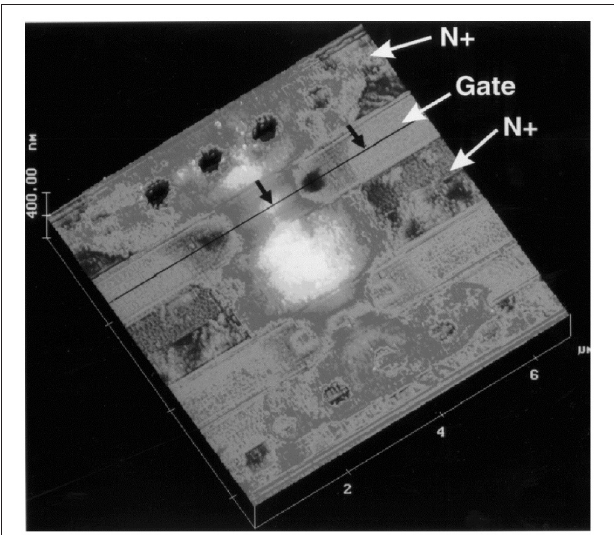
FIGURE 5 | Titanium silicide damage in 0.5 µ m CMOS technology (with permission from the ESD Association).